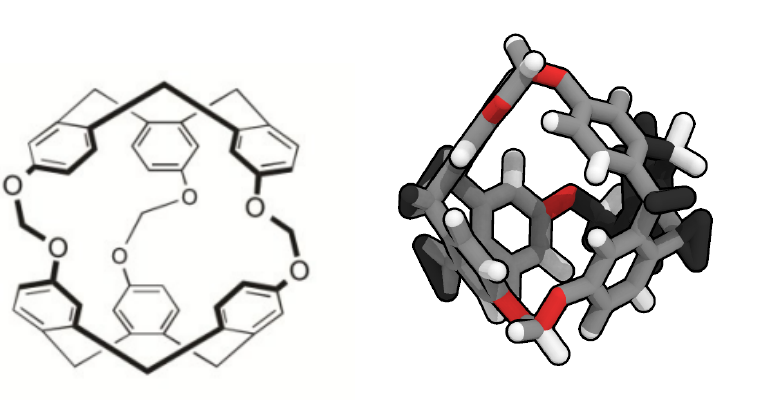
Figure 1. Chemical structure ( left ) [20] and molecular simulation model ( right ) of